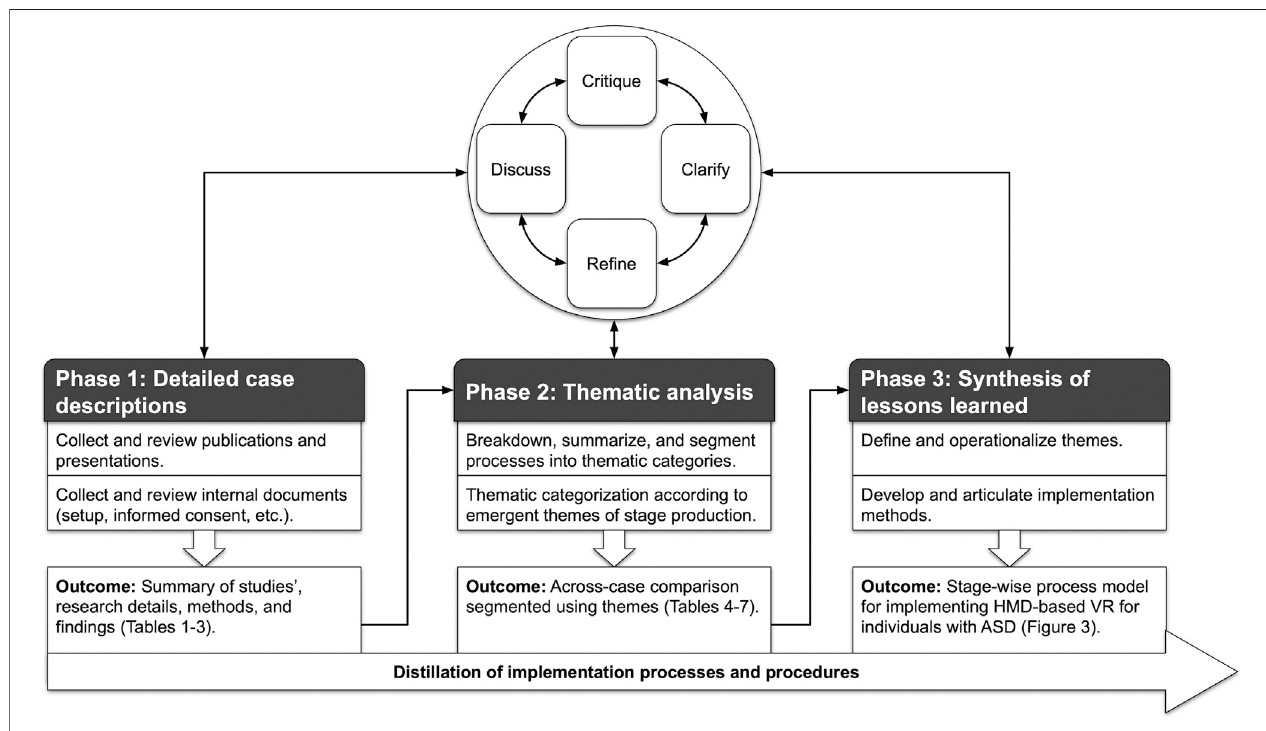
FIGURE 1 | Three-phase structured-iterative-comparative methodology used in this research.